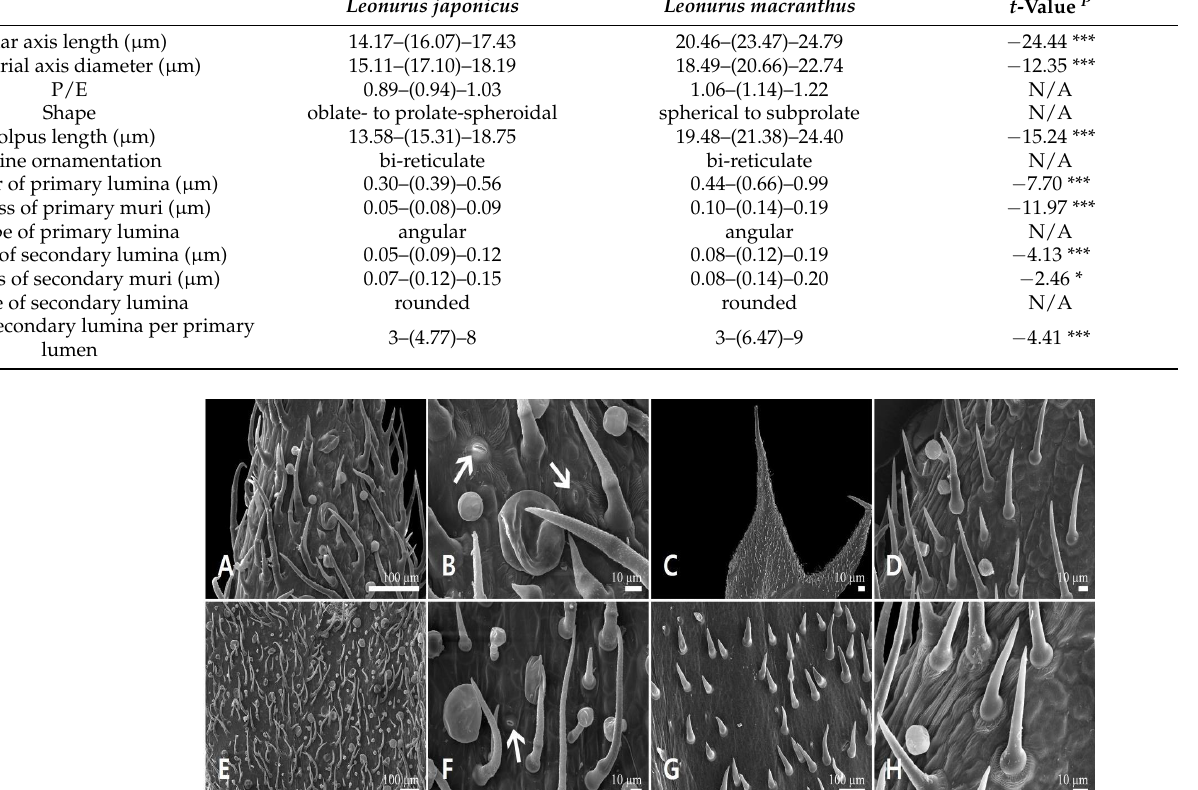
Figure 2. Scanning electron micrographs of the calyx epidermis in Leonurus japonicus . ( A , B ) Abaxial side of the calyx lobe. ( C , D ) Adaxial side of the calyx lobe. ( E , F ) Abaxial side of the calyx tube. ( G , H ) Adaxial side of the calyx tube. Arrows indicate the stomata.